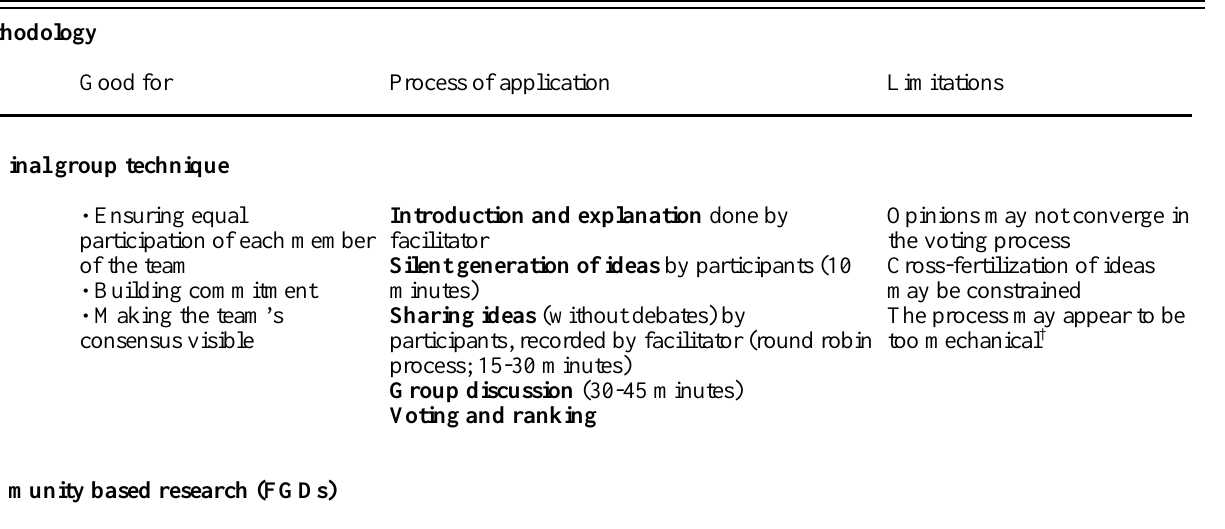
Table 2 . General description of the different participative methods used in the Amudarya Case